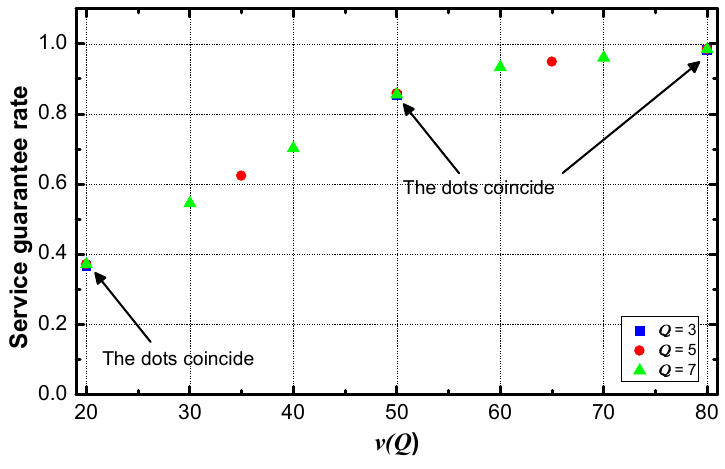
Figure 5. (cid:2025) vs. different value of service setting. Figure 5. ρ vs. different value of service setting.